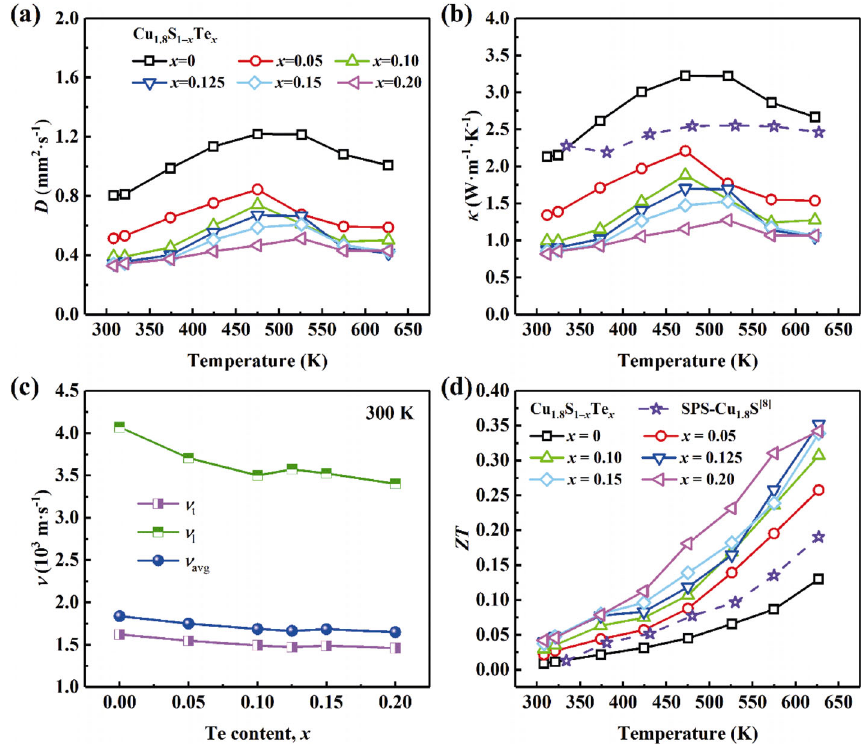
Fig. 5 Temperature dependence of thermal transport properties, sound velocities, and ZT values for Cu 1.8 S 1– x Te x bulks and the SPS-Cu 1.8 S bulk from: (a) D , (b)  , (c) sound velocity, and (d) ZT value. Reproduced with permission from Ref. [8], © The Royal Society of Chemistry